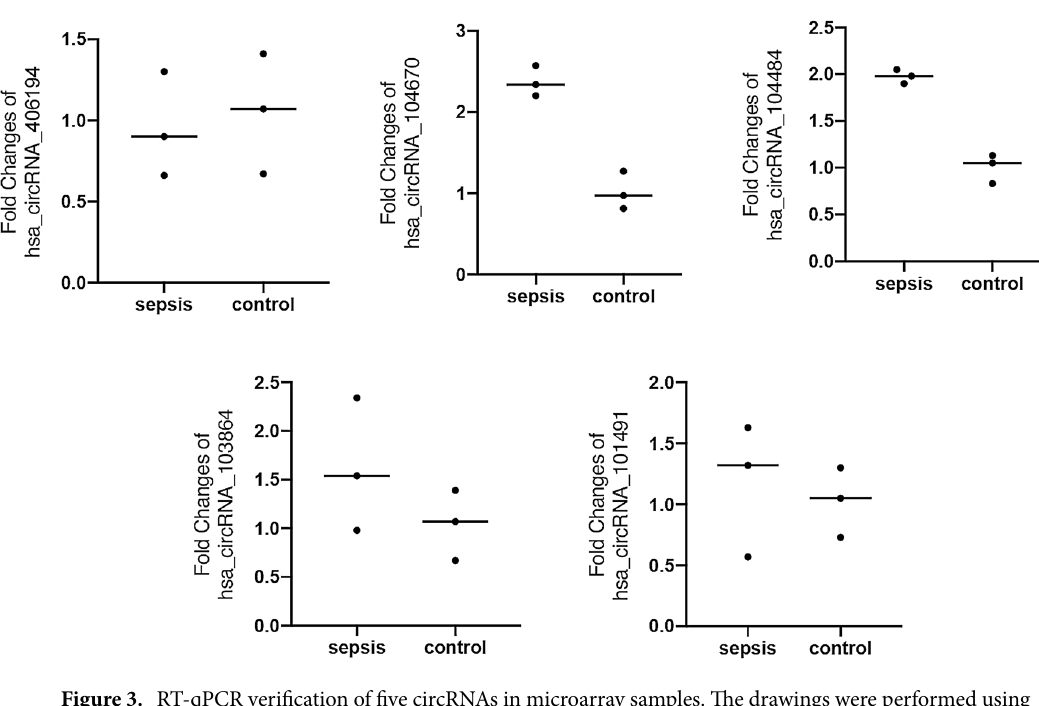
Figure 3. RT-qPCR verification of five circRNAs in microarray samples. The drawings were performed using GraphPad Prism software (version 8.0, https:// www. graph pad. com/ scien tific- softw are/ prism/).